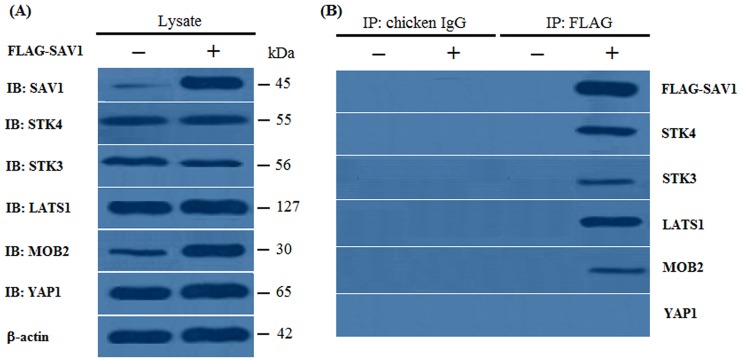
Interaction of SAV1 and STK4, STK3, LATS1, MOB2 and YAP1 by an coimmunoprecipitation experiment.Chicken GC cells were transfected with an empty pFLAG-CMV-2 expression vector (−) or pFLAG-SAV1 expression construct (+). After transfection for 24 h, the cells were lysed, and the lysates were immunoprecipitated with a control chicken IgG or an antibody to FLAG. The lysates (Lysate) and immunoprecipitates (IP) were analyzed by immunoblotting (IB) with SAV1, STK4, STK3, LATS1, MOB2 and YAP1 antibodies. (A) When the empty pFLAG-CMV-2 vector was used as a template (Lysate, −), endogenous SAV1 was detected with a faint band observed, when the pFLAG-CMV-2-SAV1 construct was used as a template (Lysate, +), SAV1 was synthesized. The endogenous STK4, STK3, LATS1, MOB2 and YAP1 expression was also detected in the lysates prior to immunoprecipitation. The β-actin was used as the loading control (B) When these lysates were immunoprecipitated with chicken IgG, no band was obtained for FLAG-SAV1in immunoprecipitates from cells expressing FLAG-SAV1, and no band was obtained for all of STK4, STK3, LATS1, MOB2 and YAP1(IP: chocken IgG). When the lysates were immunoprecipitated with an antibody to FLAG, endogenous STK4, STK3, LATS1 and MOB2 was coimmunoprecipitated in cells expressing FLAG-FOXL2 (IP: FLAG, +), but YAP1 was not coimmunoprecipitated in the cells. No one of the proteins was examined in the cells expressing the empty expression vector (IP: FLAG, −).